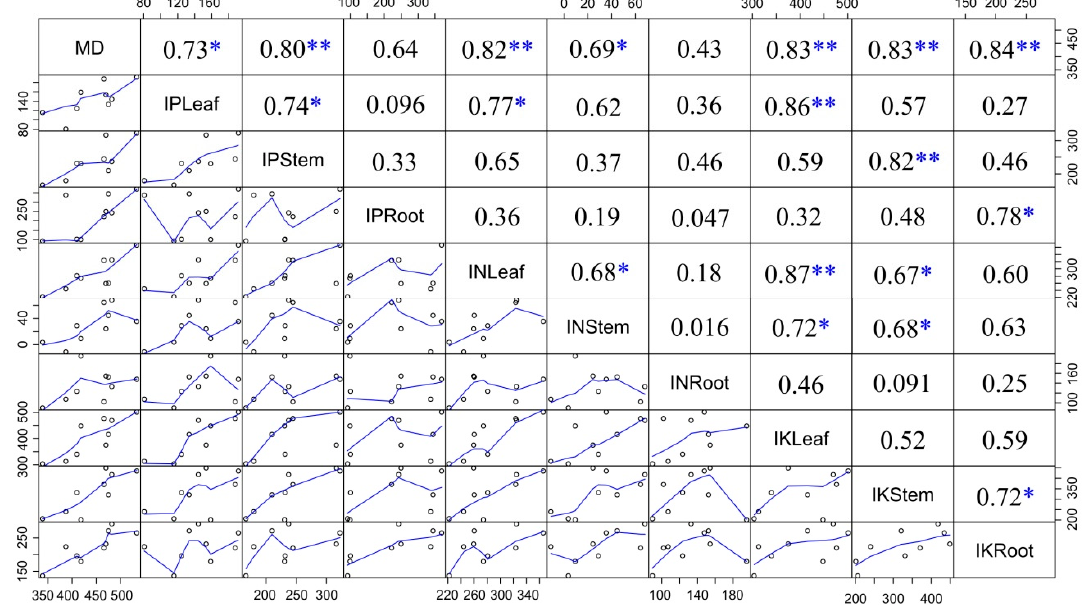
Figure 2. Correlative analysis of mycorrhizal dependence and contribution of AMF on nutrients. MD—mycorrhizal dependency; IPLeaf, IPStem, IPRoot represent the increased P content in the leaf, stem and root; INLeaf, INStem, INRoot represent the increased N content in the leaf, stem and root; IKLeaf, IKStem, IKRoot represent the increased K content in the leaf, stem and root; * p < 0.05, ** p < 0.01, *** p < 0.001.